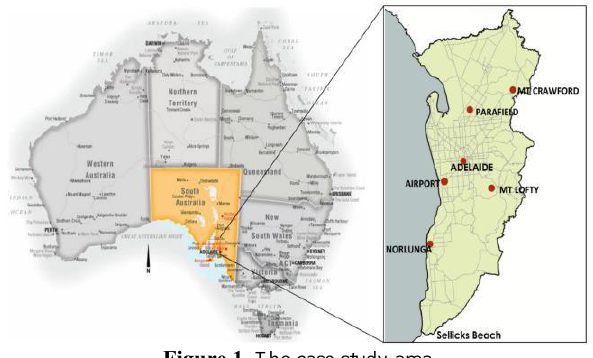
Figure 1. The case study area Adelaide was the third most liveable city in the world in 2021. It has 30% open green space. Adelaide is Australia's first and Table 1. UGS access standards in the world the world's second globally recognised National Park City ( Hsu , et al.,2022,P4 ) (Green Adelaide, 2022). Green space throughout Adelaide has a fragmented pattern around the central part of the mero, concentrating in the Adelaide Hills district, a cluster of national parks and reserves such as Belair National Park (Hsu et al., 2022). Green spaces cover 10.81% of Greater Adelaide and provide 272.21 m² UGS per capita for all residents (Hsu et al., 2022).